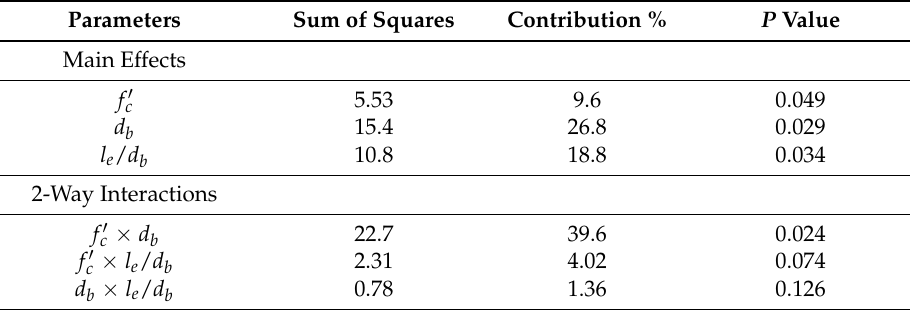
Figure 4. Normal probability plot for identifying significant and nonsignificant factors for Chaallal (1993) [11] results. Table 1. Factorial design results for main effects and significant